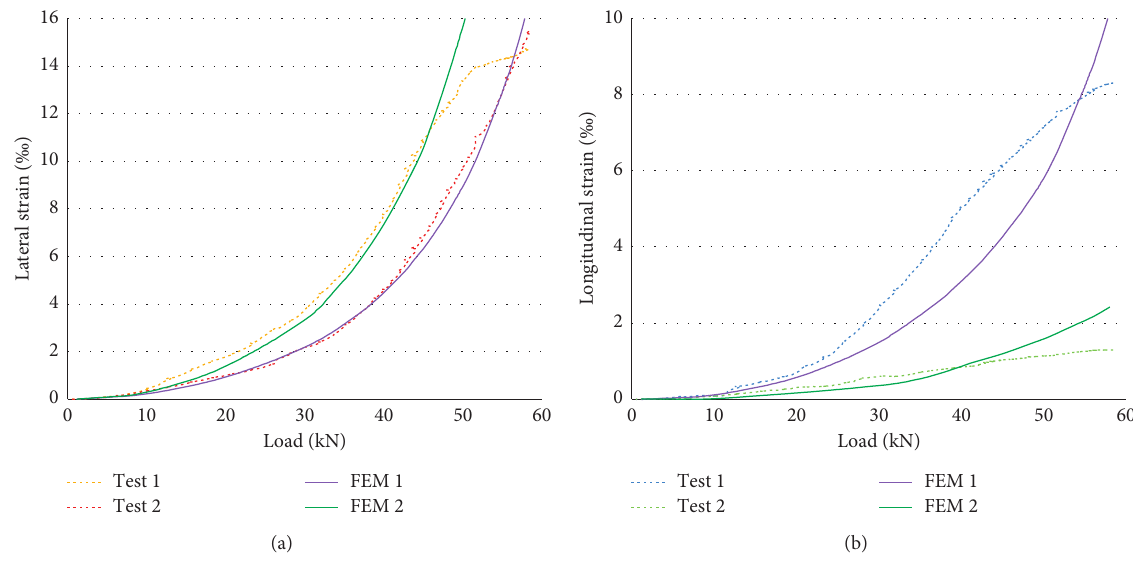
Figure 11: Experimental and FEM load strain curves. (a) Transverse strain comparison. (b) Longitudinal strain